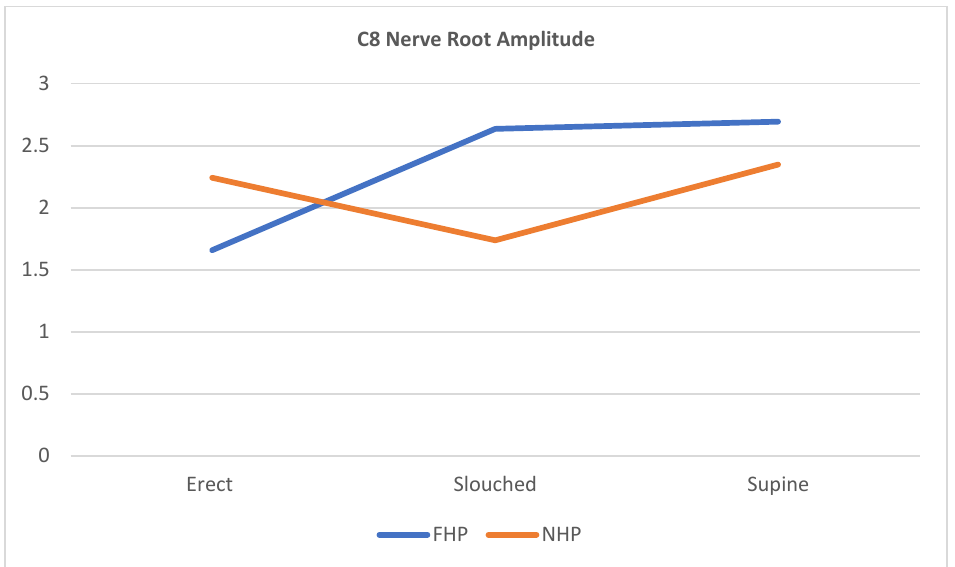
Figure 8. Scatterplot line of cervical nerve C7 amplitude relationship with the different sitting positions for participants with forward head posture (FHP) and normal head posture (NHP). The graph highlights that the FHP group has shown an increased amplitude during slouched sitting compared to erect sitting. The supine position shows the highest nerve peak from all three positions.